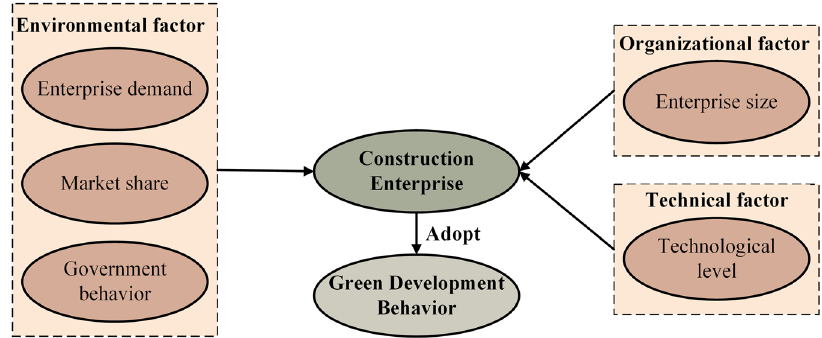
Fig. 1 An analytical framework for the factors in fl uencing construction enterprises ’ adoption of green development behaviors. Environmental factors, organizational factors and technical factors in the TOE framework in fl uence construction enterprises ’ adoption of green development